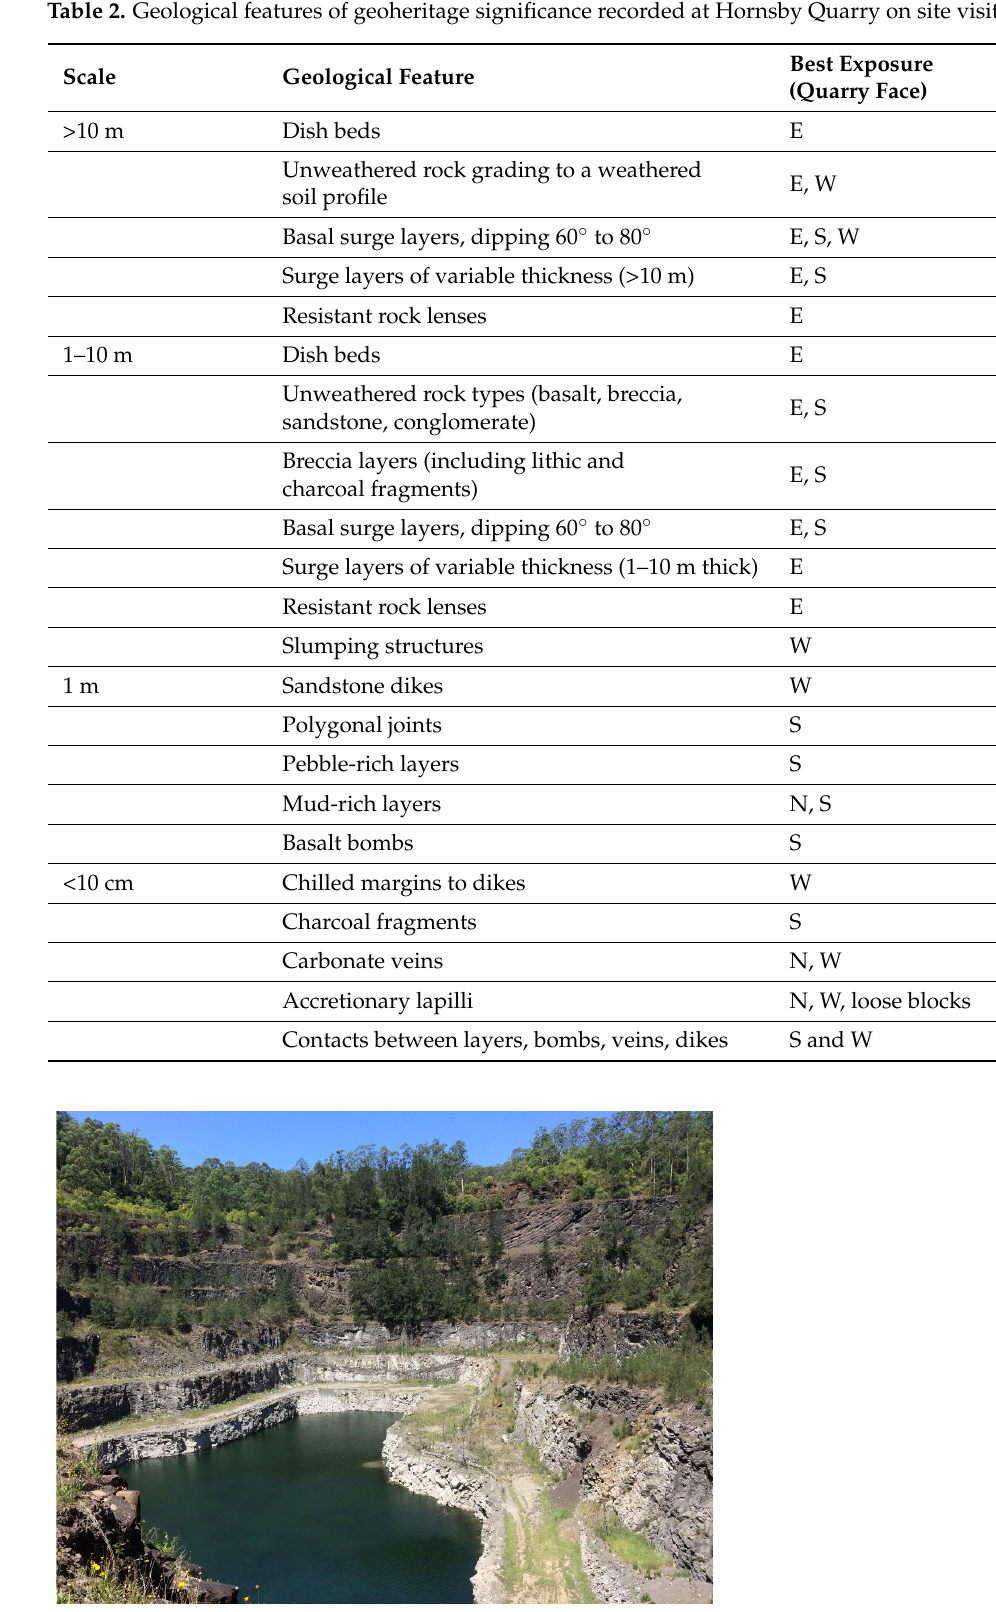
Table 2. Geological features of geoheritage significance recorded at Hornsby Quarry on site visits.